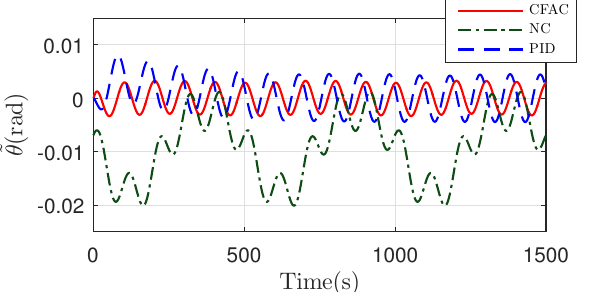
Figure 7. Pitch angle tracking error in submerging motion with a variable velocity and constant pitch angle command.